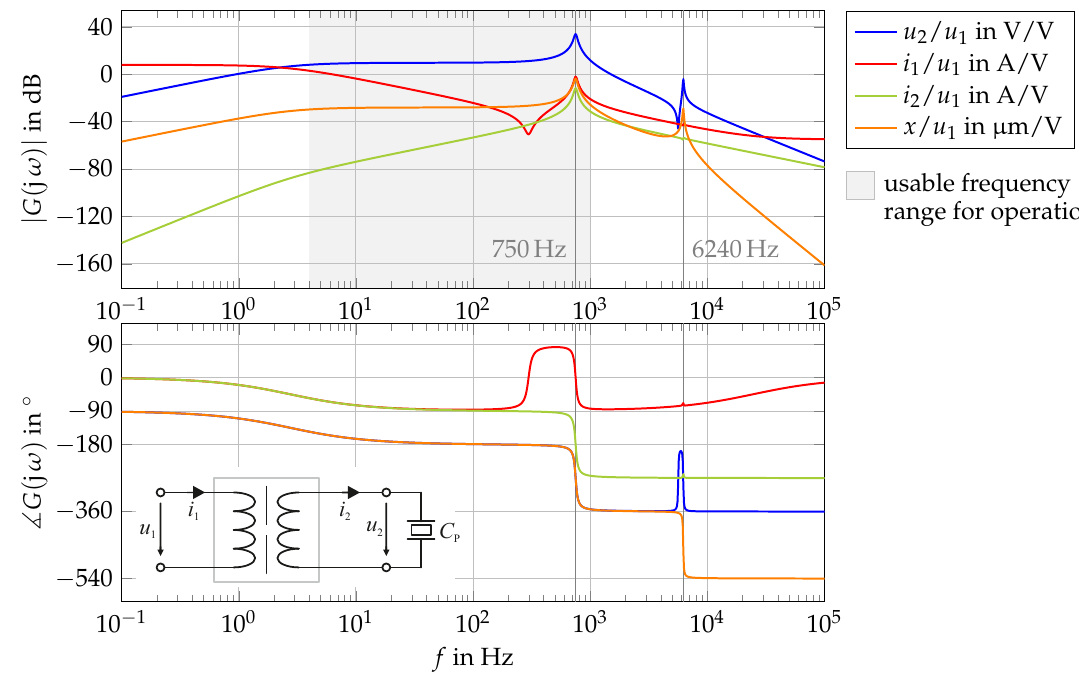
Figure 8. Frequency responses of various process parameters of the modelled